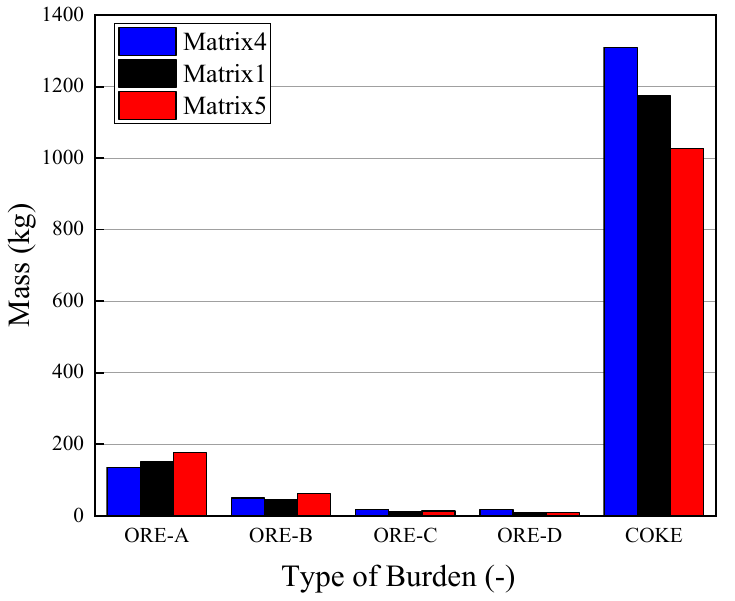
Figure 19. Distribution of charge in the sampling area under different burden matrices with simultaneous changes in coke and ore angles in the matrix.